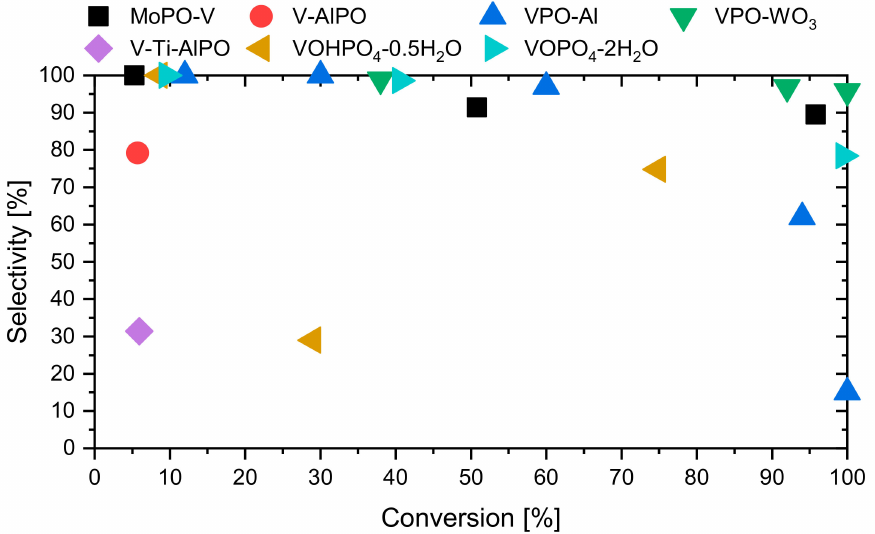
Figure 26. Summary of catalytic test results for vanadyl phosphate catalysts in the literature [157,163–165]. Vanadium mixed metal oxides and supported catalysts. In an investigation con- ducted by Klissurski and Pesheva [166], the temperature dependence of pure vanadia was investigated. The selectivity went from 100% at 250 ◦ C to approximately 70% at 430 ◦ C with 3.8 vol.% MeOH in the feed (O 2 concentration not specified) [86]. Smith et al. [167] investigated vanadia supported on SBA-15 at temperatures of 300–400 ◦ C with 4 vol.% MeOH and 10 vol.% O 2 in the feed. The selectivity to FA